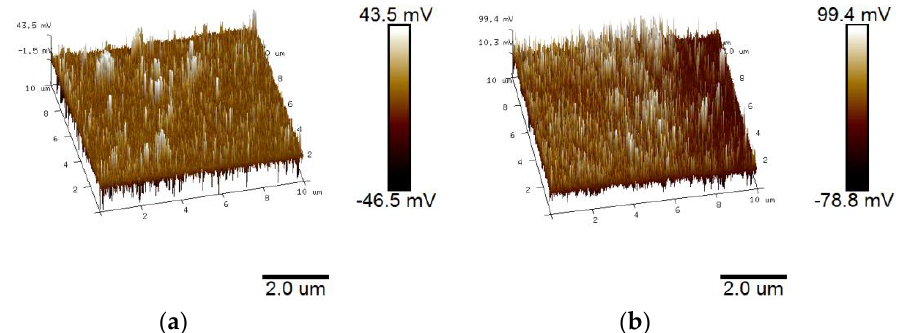
Figure 8. Atomic force microscopy (AFM) of polyurea coating ( a ) 3D phase contrast image of PCB; and ( b ) 3D phase contrast image of PCA.